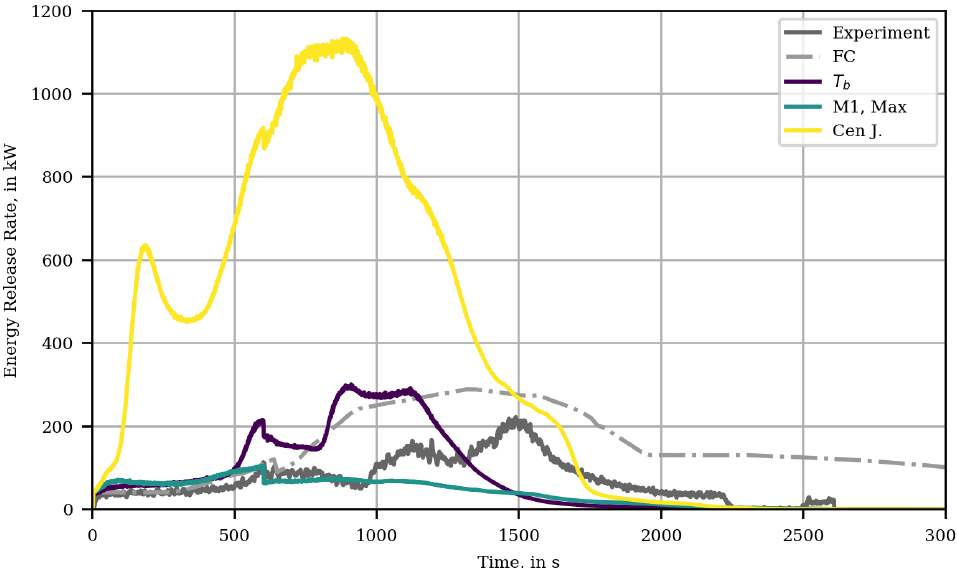
Figure 8. MT3 simulation results for different Cone Calorimeter Paint methods and T b results are provided for comparison. Label “M1” refers to a specific method of the “Beji-Merci” procedure [32], “J.” refers to the Janssens’ procedure [45].